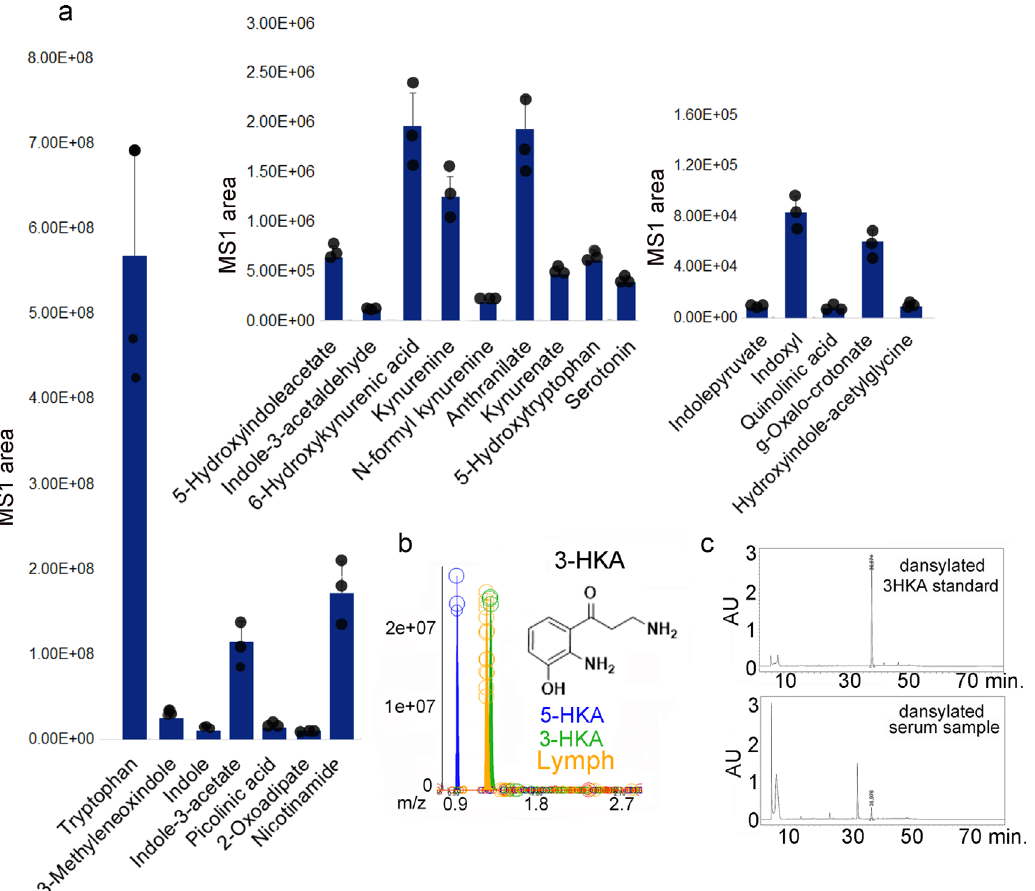
Fig. 1 Lymphatic fl uid contains several tryptophan metabolites. a Bar graphs reporting the MS1 area of tryptophan metabolites detected in the human lymph. Bar graphs represent MS1 average readings ± SD of n = 3 biological replicates. Source data are provided as a Source data fi le. b Standards used for identi fi cation/quanti fi cation of 3-hydroxykynurenamine (3-HKA) vs 5-hydroxy- L -kynurenamine by mass spectrometry. c 3-HKA was reacted with dansylchloride producing the di-dansylated 3-hydroxykynurenamine derivative (Supplementary Figs. 1 and 2). The stable derivatization product was quantitatively analyzed by